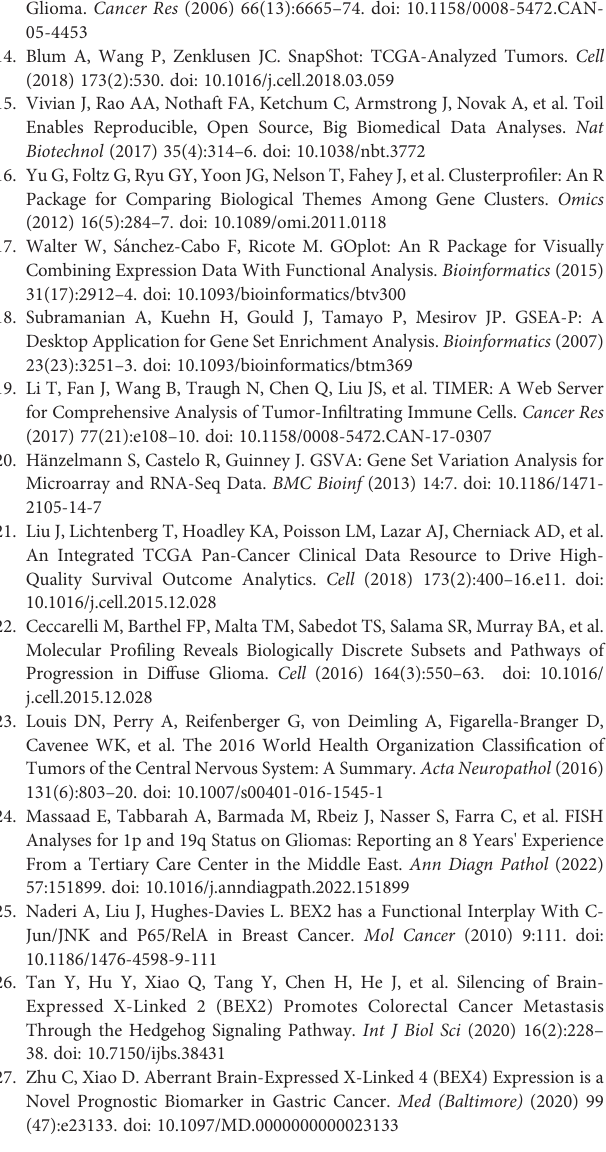
Supplementary Figure 5 | Enrichment plots from gene set enrichment analysis (GSEA). PD-1signaling, CTLA4 pathway, DNA methylation and P53 signaling pathway et al. were enriched in low BEXs expression phenotypes and might be closely correlated with prognosis of GBM. Supplementary Figure 6 | Relationship between 7 Independent prognostic value genes and other clinical factors with overall survival (OS). (A) Nomogram for predicting the probability of 1-, 3-, and 5-year OS for GBM patients. (B) Calibration plot of the nomogram for predicting the OS likelihood. (Concordance, C-index: Supplementary Figure 7 | The immunohistochemical staining of the BEX family genesinnormalbraintissuesandGBMtissuesofdifferentgrades:BEXfamilygenes generally stained medium to high in brain tissues, especially in neuronal cells, when they stained medium to low in high grade GBM and stained low or not detected in low grade GBM. (except for BEX3,which stained high in low grade